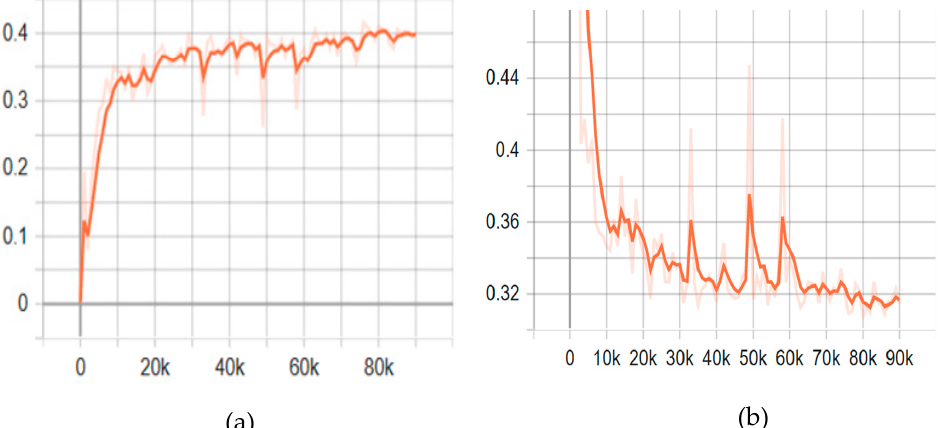
Figure 18. Training performance of datasets using EfficientDet ( a ) precision curve (mAP@0.5) and ( b ) total loss curve. Table 1. Performance evaluation summary of training datasets for apple detection models.